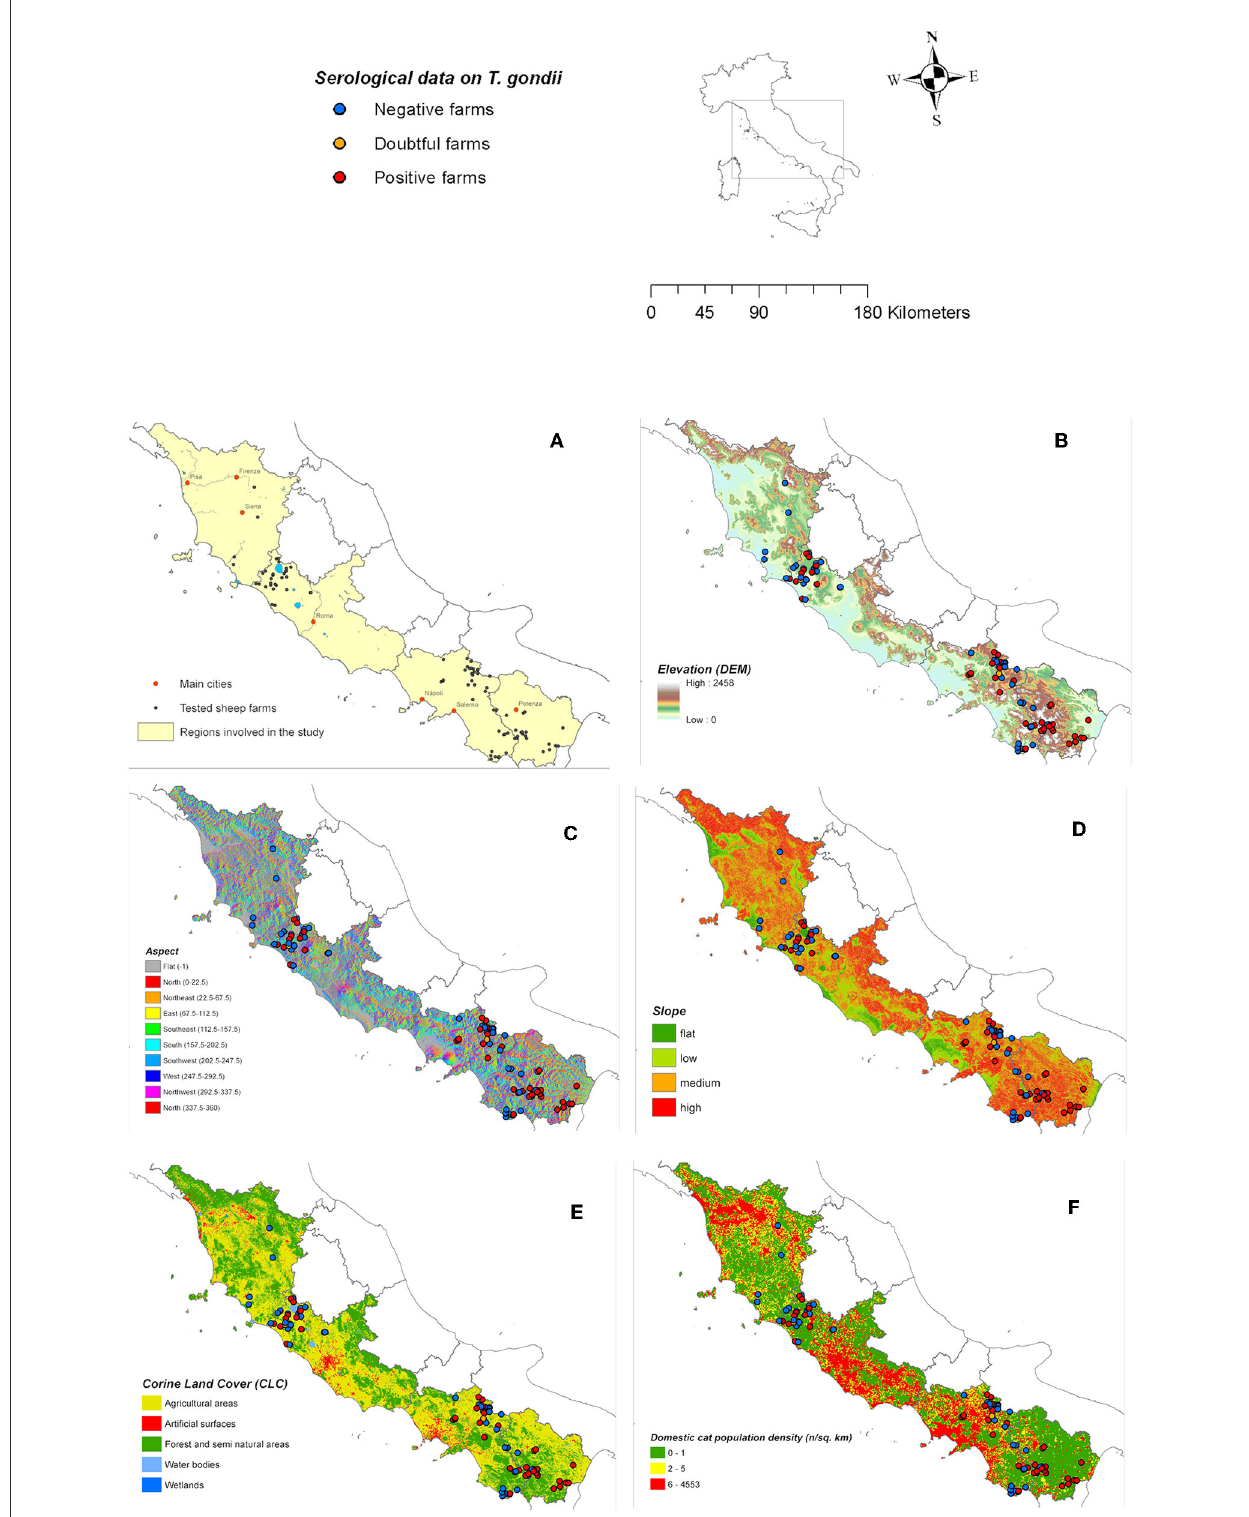
FIGURE1 A map of serological results and location of the farms included in the investigation (A) presented by elevation (B) , predominant aspect (C) , slope steepness (D) , Corine Land Cover classes (E) , and estimated domestic cat population density (F) in the study area. The positive farm was defined on the basis of at least one positive serological